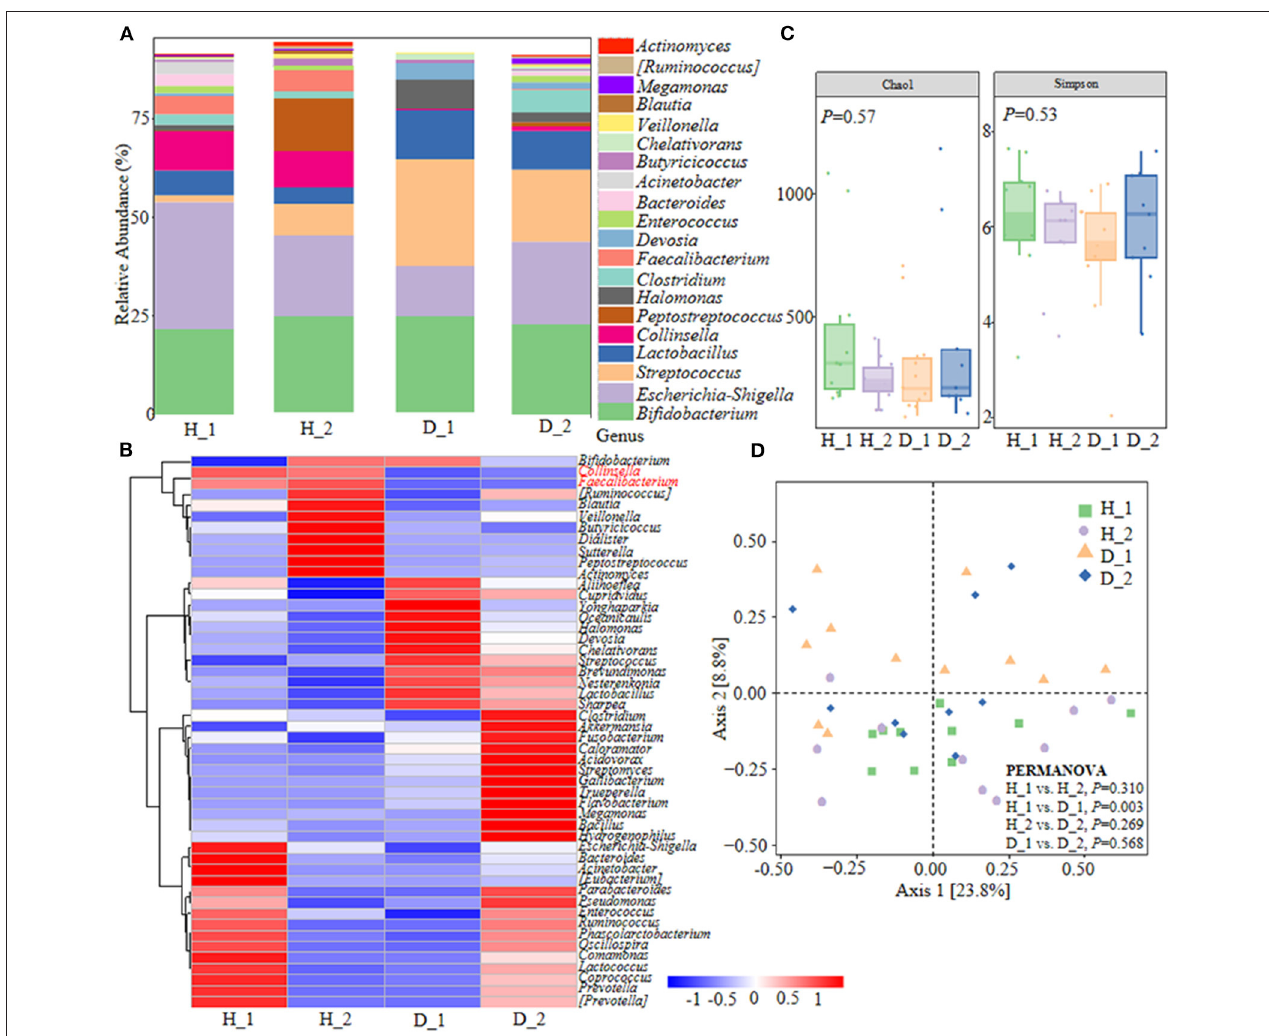
FIGURE 1 | Gut microbiota assembly of neonatal calves post extended-spectrum β -lactamase-producing enteroaggregative E. coli (ESBL-EAEC) infection. (A) Calf fecal bacterial genera’s relative abundance is represented by 99.5% of their community. (B) Top 50 bacteria of fecal samples presented using heat map analysis in diarrheal-D or healthy-H calves. The color indicated the relative abundance of the bacteria in the group of samples, and the corresponding relationship between the color gradient and the value was shown in the gradient color block. Collinsella and Faecalibacterium were labeled red. (C) The α -diversity of different groups by Chao1 and Simpson indices. Data were mean ± SEM. P- values were determined using the nonparametric Kruskal-Wallis test. (D) Principal coordinate analysis (PCoA) of fecal bacteria based on the weighted UniFrac distance matrix. The statistical tests were accomplished using permutational multivariate ANOVA (PERMANOVA) with 999